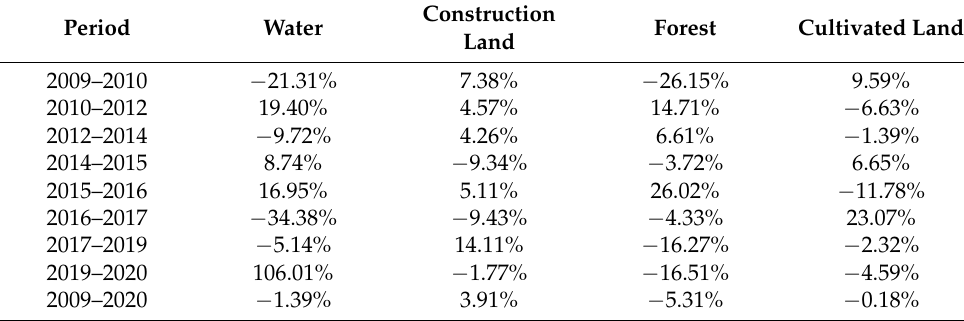
Table 9. Land-use dynamic index in research area.